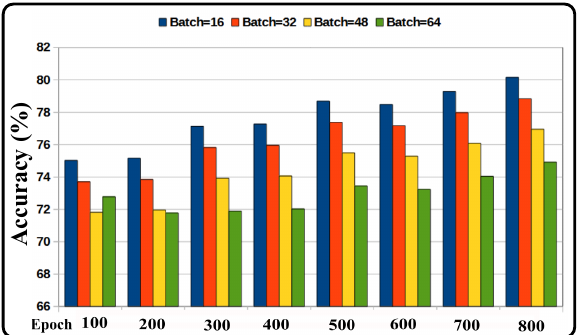
Figure 11. Effect on the performance of the proposed FERS due to the trade-off between epochs and batches using CNN 1 architecture for the CK+ database.